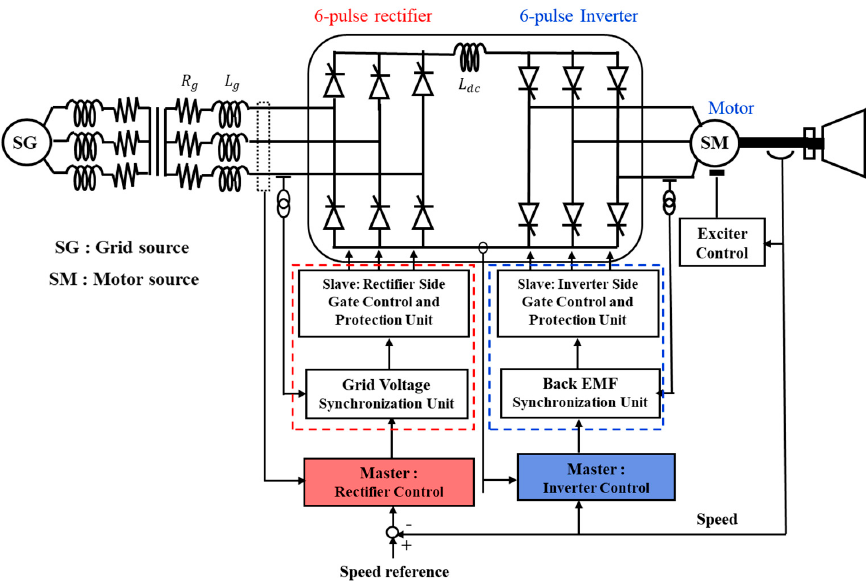
Figure 12. Simplified representation of the simulated 6/6-pulse LCI system with a 3-phase syn- chronous motor.